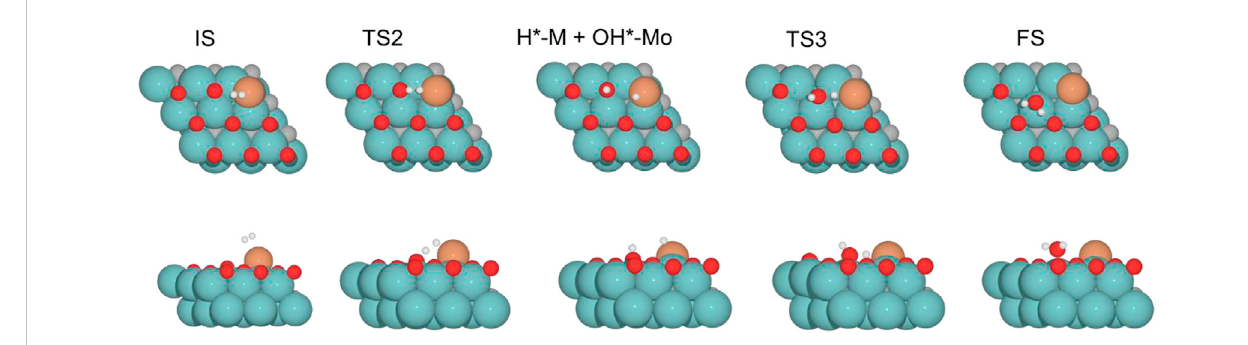
FIGURE 6 Top and side views of structures of initial state (IS), intermediate, transition state (TS), and fi nal state (FS) on Fe/Mo 2 C of 0.78 O ML coverage for H 2 splitting and the formation of H 2 O (see Supplementary Figures S4-6 for the structures of other intermediates and TS on 0, 0.33, and 0.67 O* ML